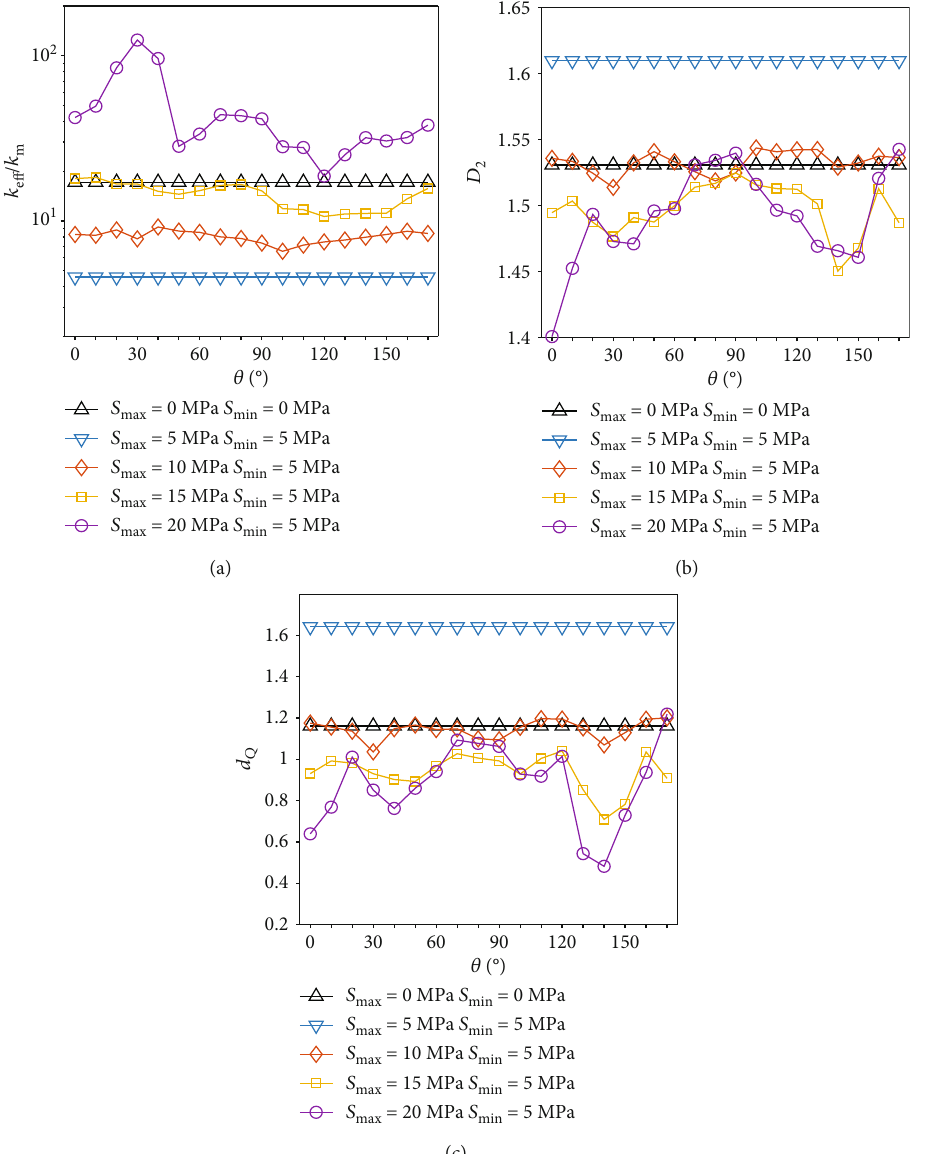
Figure 9: Quantitative indices for evaluating fl ow magnitude and distribution in fracture networks under di ff erent stress conditions: (a) e ff ective permeability, (b) correlation dimension of fl ow rate, and (c) fl ow channeling density